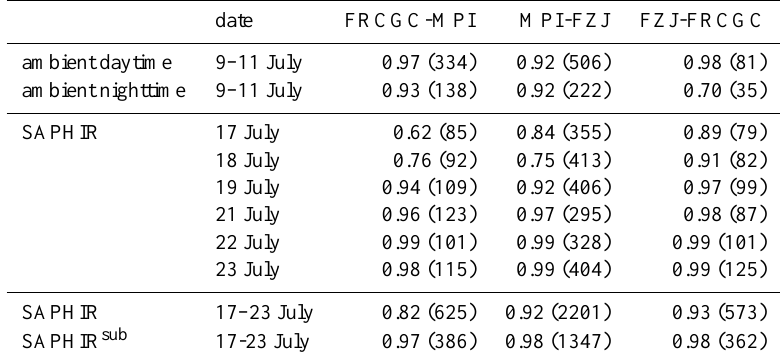
Table 3. Linear correlation coefficient R 2 between data measured by different LIF instruments. Results are shown for measurements in ambient air and in chamber experiments (SAPHIR). Numbers in brackets are the number of valid data points (1min average). Data after noon on 22 July were excluded (see text for